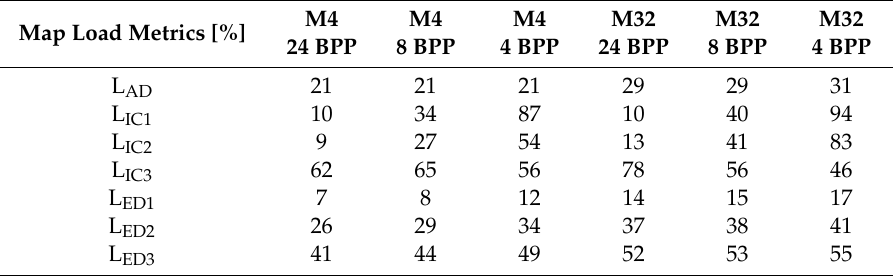
Figure 15. Dotted structures caused by colour depth reduction in the case of M4. Table 2. Map load values (in %) of M4 and M32 with decreased bit